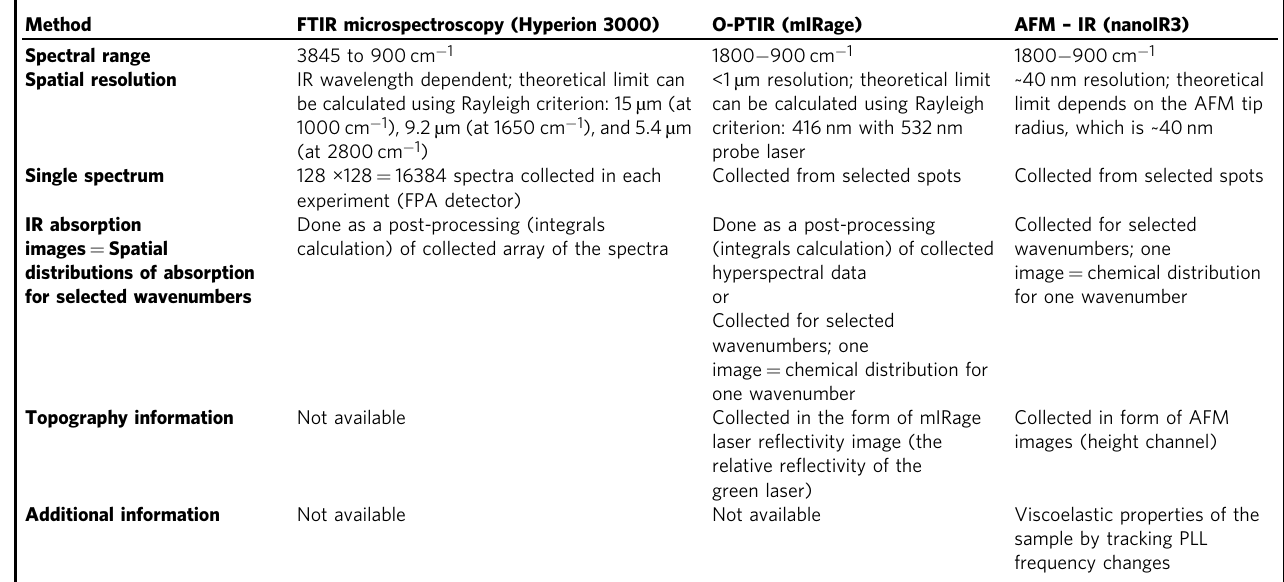
Table 2 Summary of all spectroscopic experiments performed on Plasmodium- infected RBC